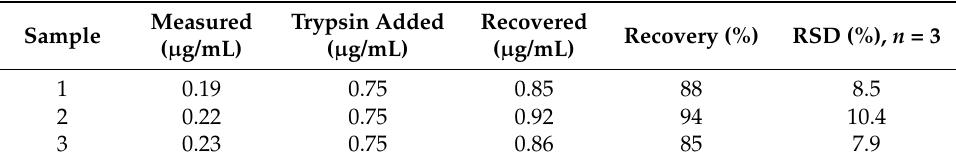
Table 1. Analytical results of trypsin determination in human